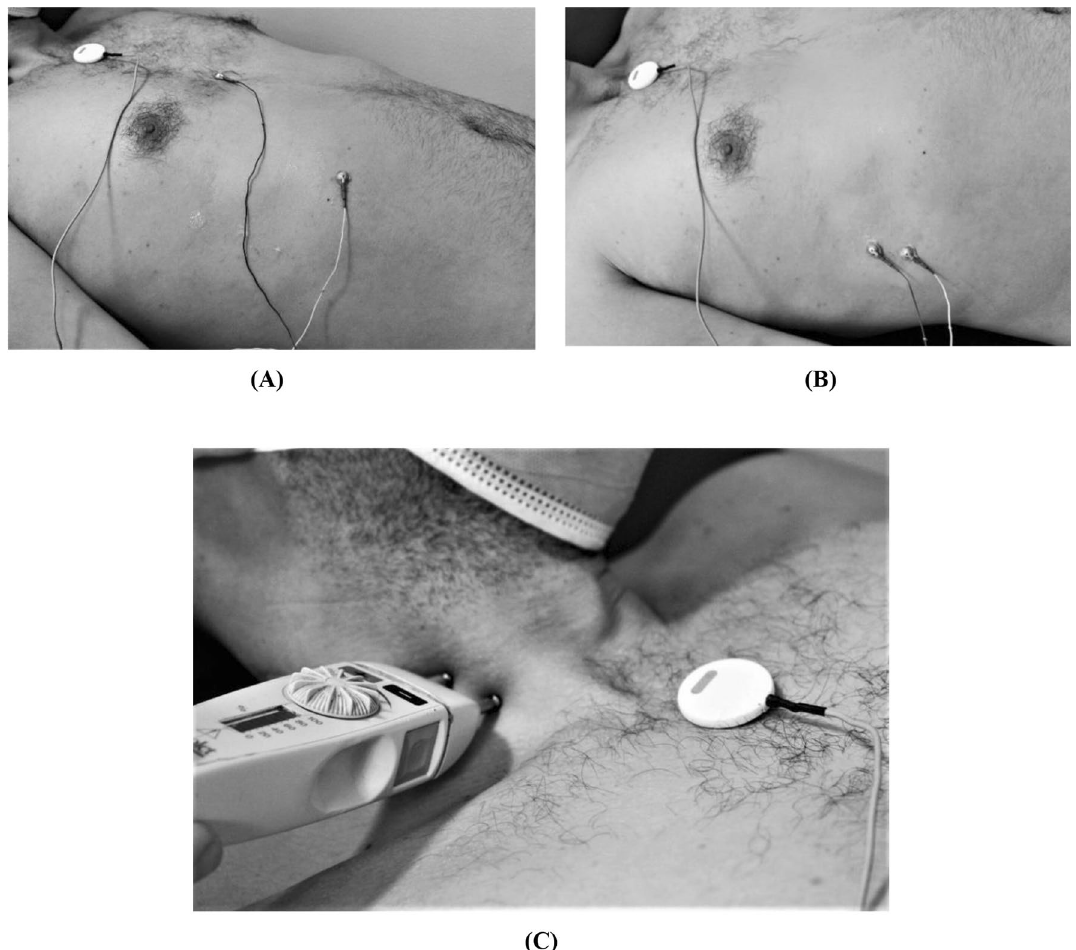
Figure 1. Position of the stimulating and recording electrodes of the phrenic nerve conduction study. ( A ) Sternal recording; active electrode was placed 5 cm superior to the tip of the xiphoid process and the reference was placed 16 cm from the xiphoid process at costal margin ipsilateral to the stimulation site. ( B ) LCW recording; active electrode over the 7th intercostal space at the anterior axillary line and the reference electrode at the 8th intercostal space ipsilateral to the stimulation site. ( C ) Position of the stimulating electrode at the posterior border of the sternocleidomastoid muscle at the level of the cricoid